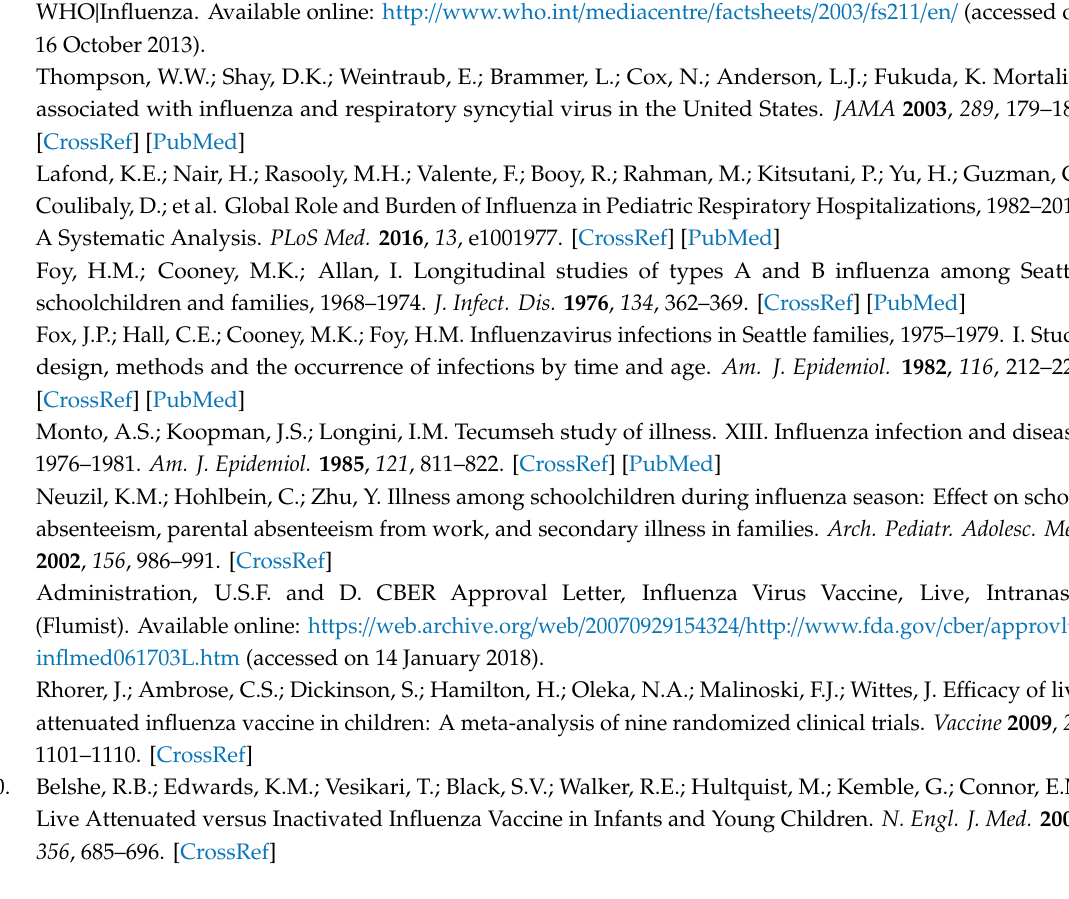
Figure S1: H1N1 and H3N2 pre / post-vaccination HAI titer change distribution by vaccine type, Figure S2: H1 and H3 pre / post-vaccination serum IgA endpoint titer change distribution by vaccine type, Figure S3: H1 and H3 pre / post-vaccination mucosal IgA titer change distribution by vaccine type, Figure S4: Relationship between pre-vaccination antibody titers and post-vaccination response, Figure S5: Binary quantification of mucosal IgA